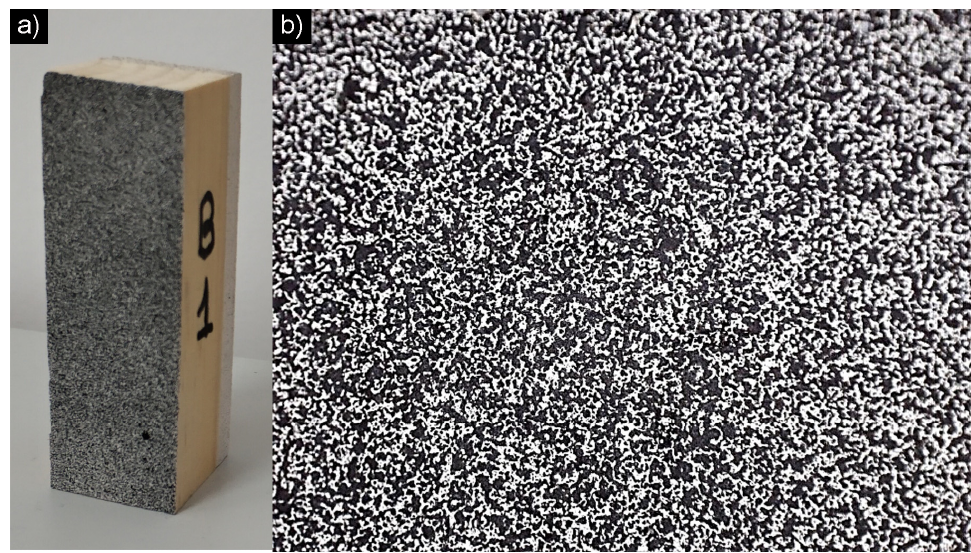
Figure 2. ( a ) Application of black speckled on a white base and ( b ) example of speckled